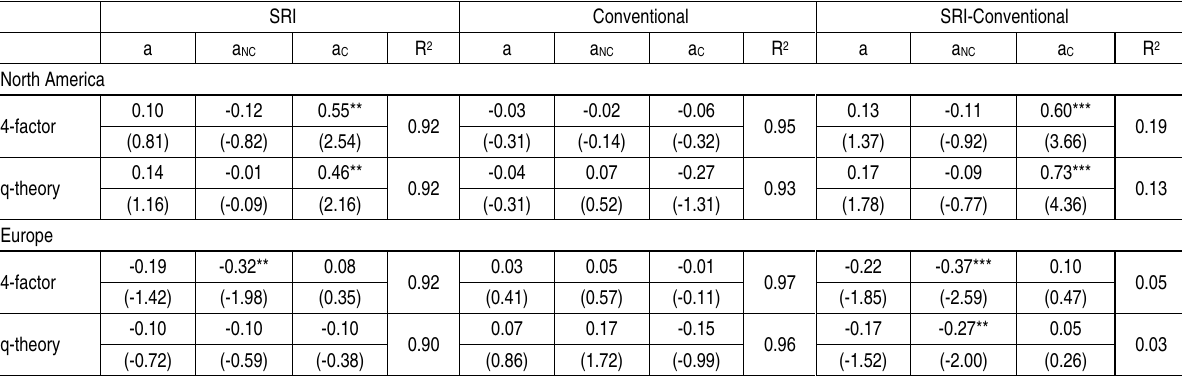
Table 2. Financial performance: alpha estimates of the North American, European, and Asian-Pacific sub- portfolios in percent per